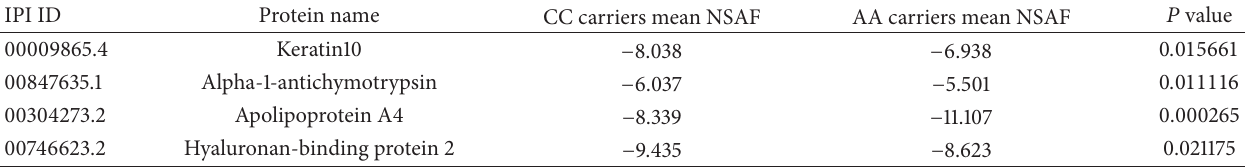
Table 2: Identification of proteins with significant differences between CC carriers and AA carriers based on NSAF